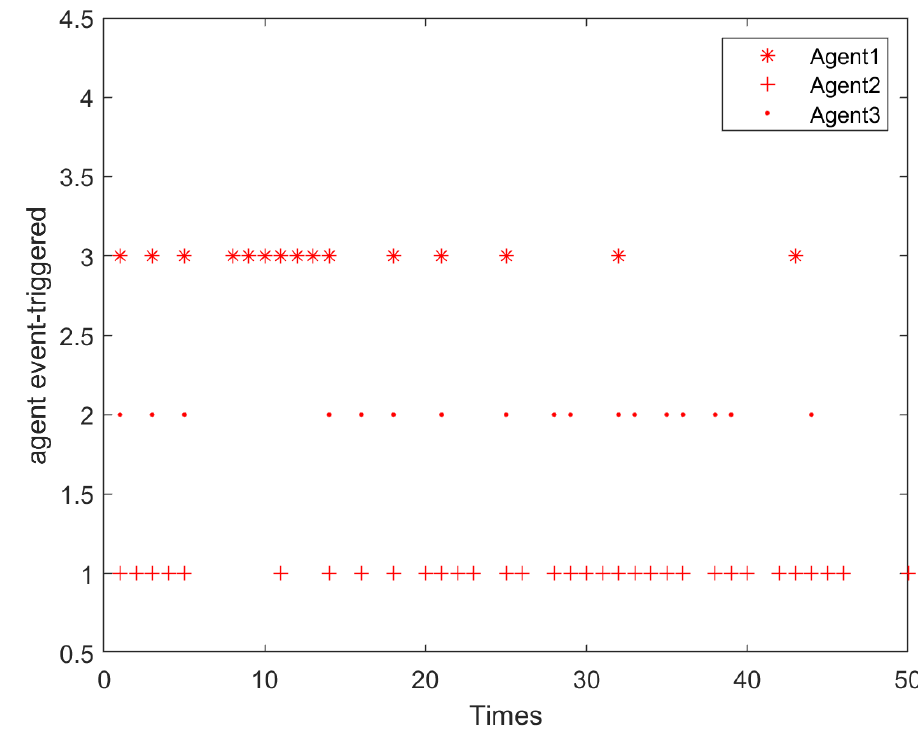
Figure 5. Triggering instants for three agents.